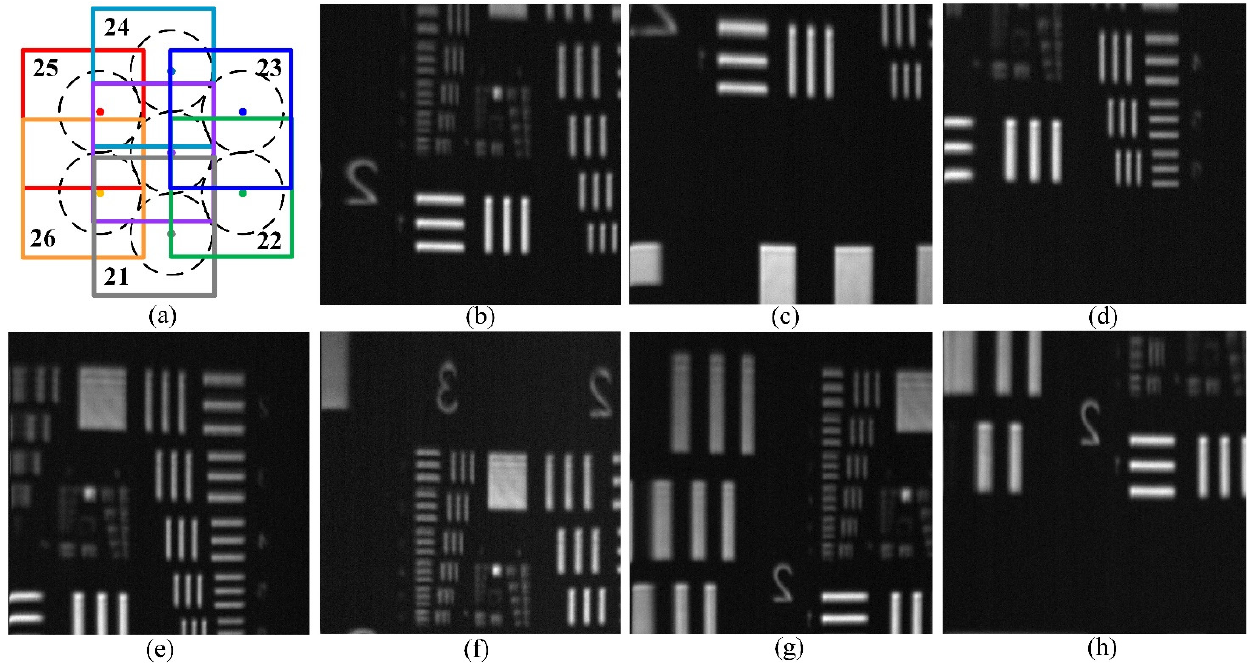
Figure 7. Scanning sub-images of each fiber with 160 × 160 points and scanning step of ~1 µ m. ( a ) Scanning optical fiber arrangement; ( b ) purple-middle; ( c ) gray-21; ( d ) green-22; ( e ) blue-23; ( f ) cyan-24; ( g ) red-25; ( h ) orange-26.